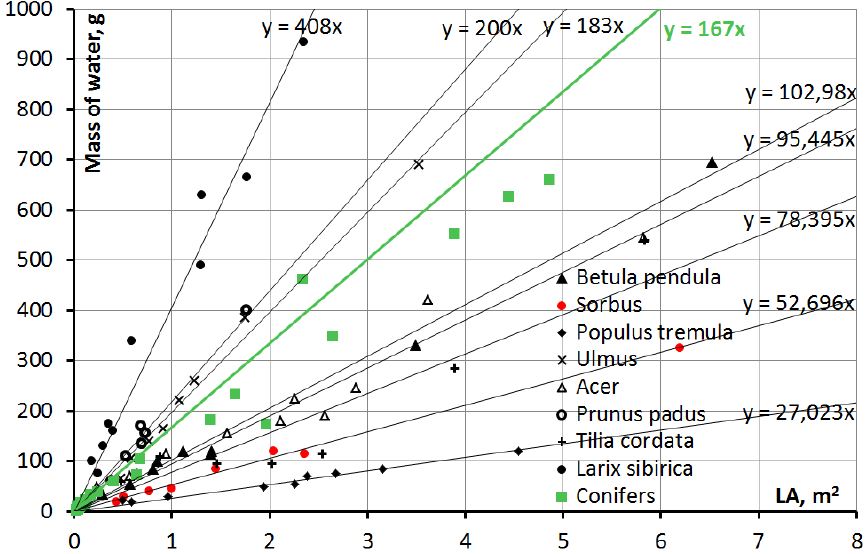
Figure 4. Dependency of the maximum mass of water retained on the leaf surface area of the analyzed species (LA, m 2 ) (data and dependencies for deciduous species are from Klimenko et al. [10,15]. The dependencies are characterized by good quality (with correlation coe ffi cients greater than 0.9